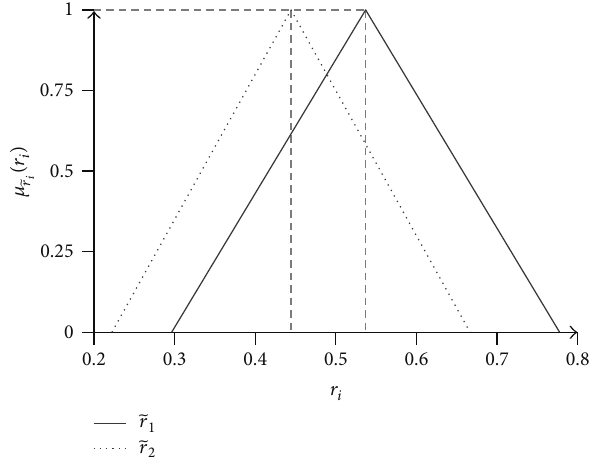
Figure 10: Membership functions of ̃𝑟 1 and ̃𝑟 2